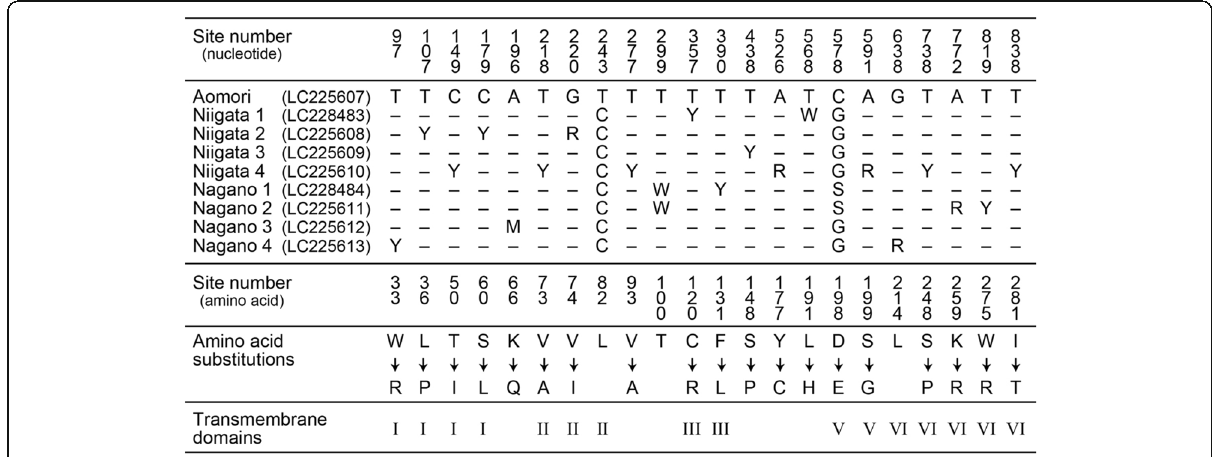
ively, which are shown individually and summed in Fig. 5a.